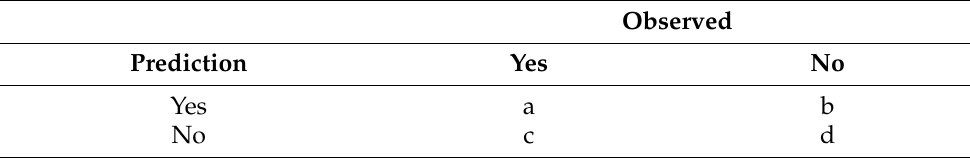
Table 3. Event frequency for each case.